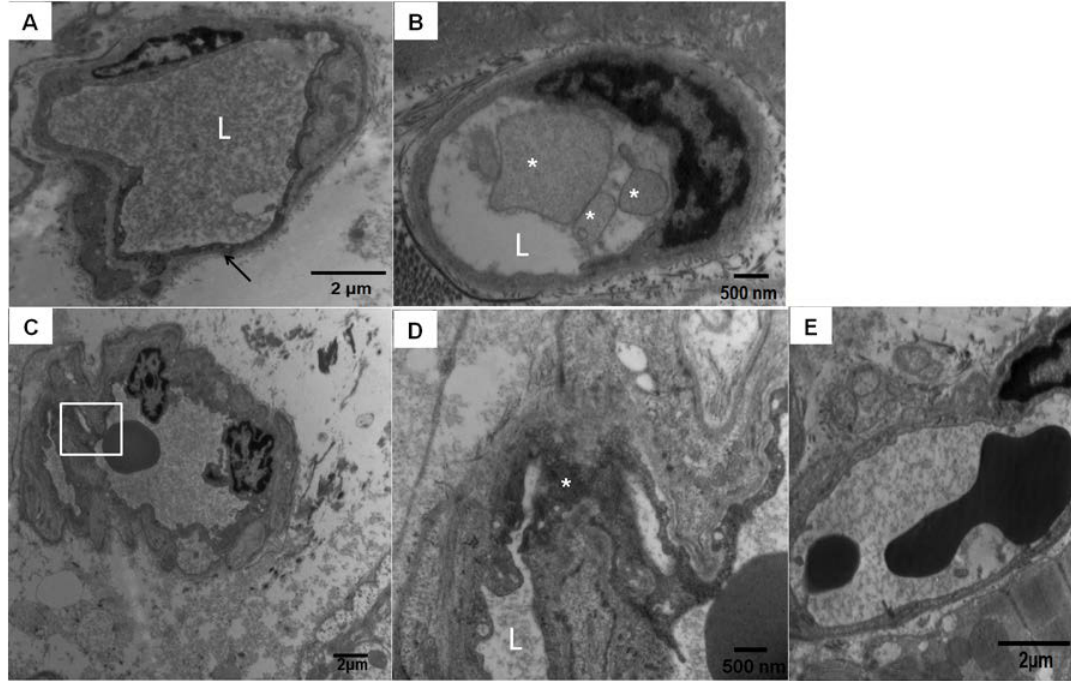
Figure 2. Mexico City dogs myocardial blood vessel pathology. ( A ) Scattered left and right ventricle capillaries exhibited endothelial cells with very dark cytoplasm, shrinkage, and partial detachment from the vessel lumen. This picture corresponds to a 4.6 years South MCMA animal facility male dog. “L” is marking the vessel lumen, magnification ×14,500; ( B ) South MCMA female dog with membranous luminal fragmented material in the vessel lumen (white *), magnification ×29,100; ( C , D ) correspond to a male 5 years old dog with numerous fine and ultrafine particulated material in the arteriolar wall (square), magnification ×7290; At ×29,100 ( D ), the conglomerates de PM are occupying the endothelial cytoplasmic space (white *); and ( E ) Normal left ventricle capillary in a 5 years old control dog, magnification